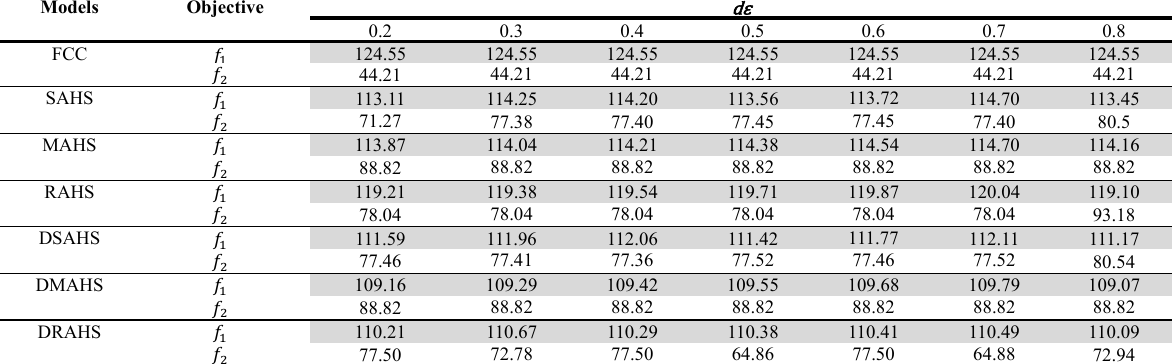
Performance of optimal solutions for different value of d ԑ Models